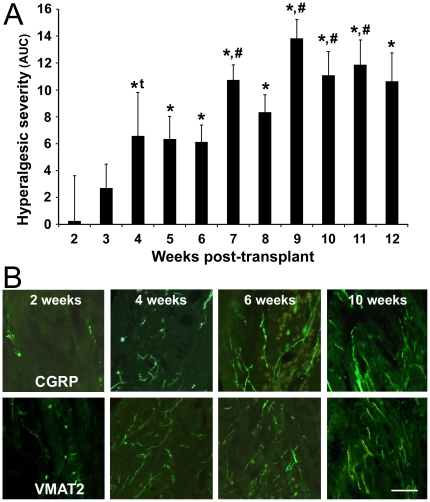
A behavioral study of the development of vaginal hyperalgesia and an immunohistochemical study of the development of cyst innervation after transplant surgery.Note that sensory and sympathetic fibers appear within the cysts two weeks before significant hyperalgesia develops. A. Hyperalgesic severity (post-transplant AUC minus baseline AUC) at different times after transplant surgery in the same rats. Error bars are ± SEM (n = 18). *, differs from two weeks; #, differs from six weeks, p<0.05. For the 4 week time point, *t = 0.058. B. Photomicrographs of sensory (CGRP-positive and sympathetic (VMAT2-positive) fibers in the cysts labeled at two, four, six, and ten weeks after transplant surgery (n = 3–5 rats/survival time). Calibration bar is 50 µm for all images.